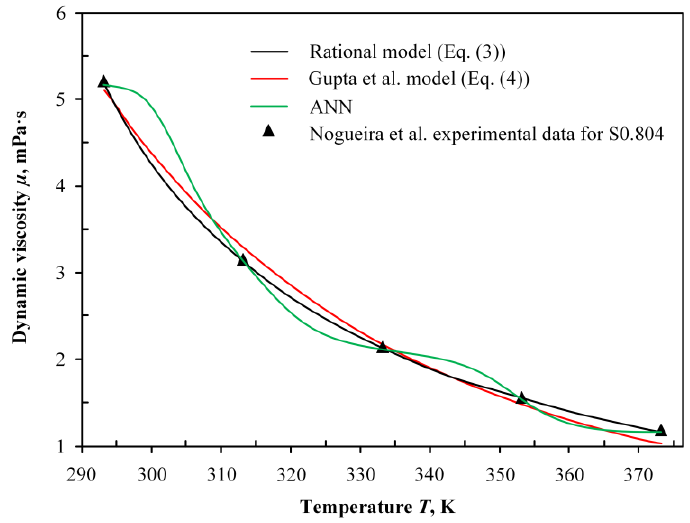
Fig. 3. Variation in dynamic viscosity of S0.804 vs.